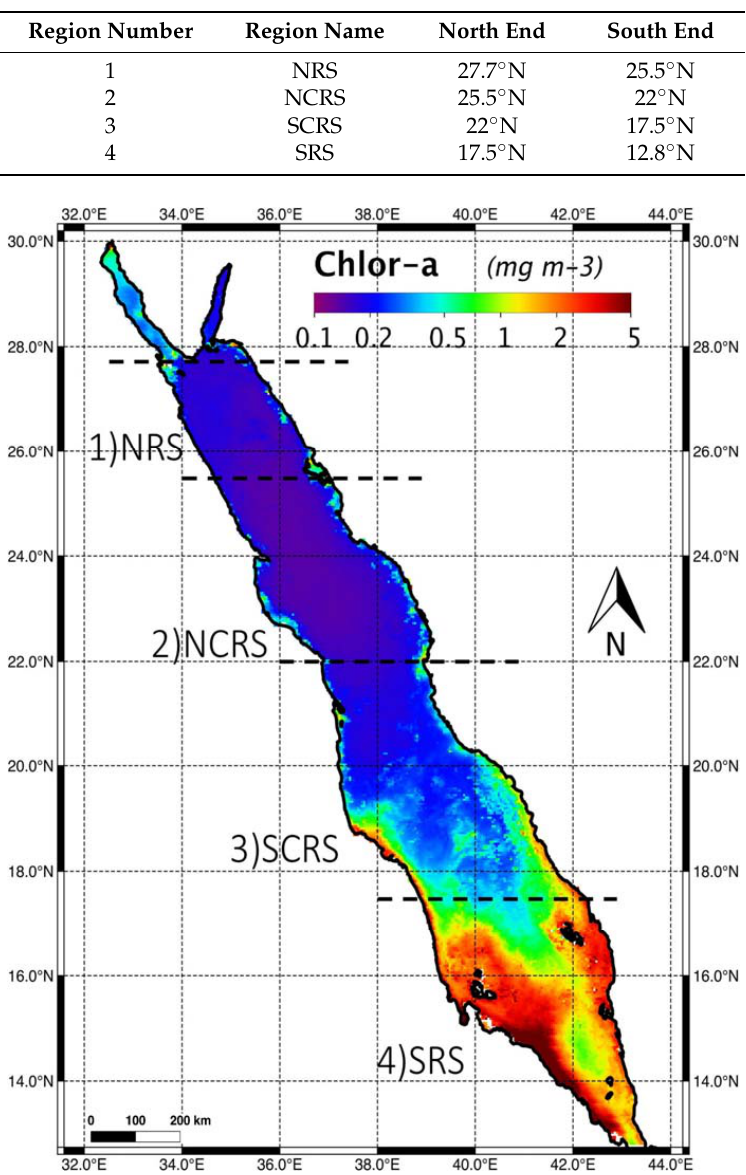
Table 1. Four Regions of the Red Sea; NRS: Northern Red Sea; NCRS: North Central Red Sea; SCRS: South Central Red Sea; SRS: Southern Red Sea.